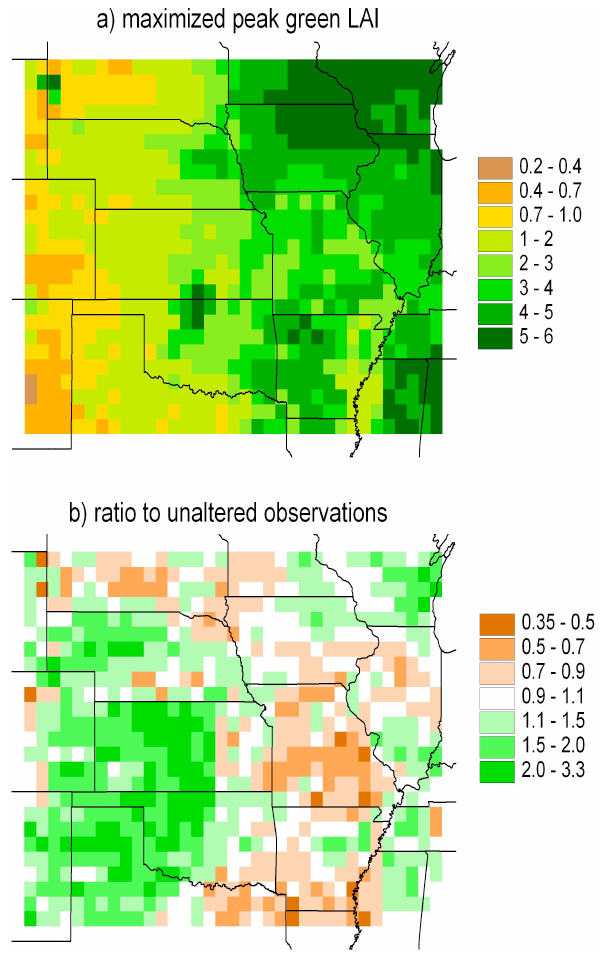
Fig. 8. (a) Average peak in model-determined green LAI (1951– 1980), and (b) its ratio to the average NDVI-based estimates (1981– 1991) of Buerman et al.